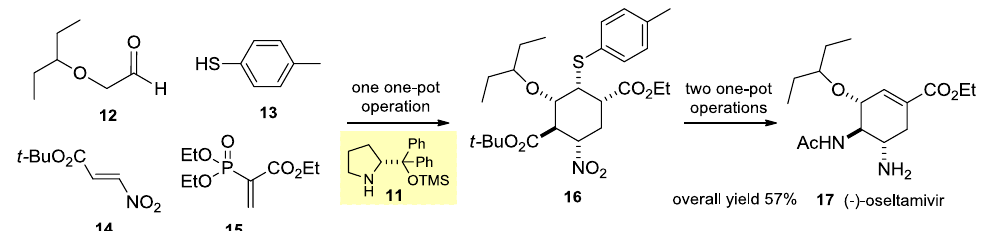
Figure 6. Oseltamivir enantioselective synthesis, see Ref. [35].